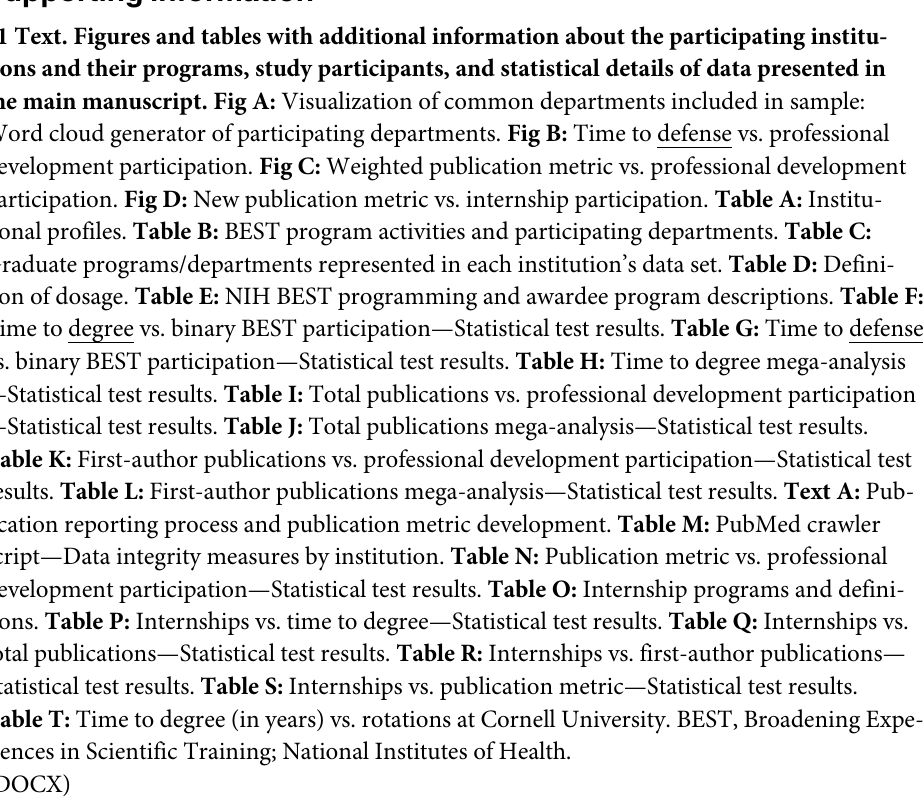
development participation. Fig C: Weighted publication metric vs. professional development participation. Fig D: New publication metric vs. internship participation. Table A: Institu- tional profiles. Table B: BEST program activities and participating departments. Table C: Graduate programs/departments represented in each institution’s data set. Table D: Defini- tion of dosage. Table E: NIH BEST programming and awardee program descriptions. Table F: Time to degree vs. binary BEST participation—Statistical test results. Table G: Time to defense vs. binary BEST participation—Statistical test results. Table H: Time to degree mega-analysis —Statistical test results. Table I: Total publications vs. professional development participation —Statistical test results. Table J: Total publications mega-analysis—Statistical test results. Table K: First-author publications vs. professional development participation—Statistical test results. Table L: First-author publications mega-analysis—Statistical test results. Text A: Pub- lication reporting process and publication metric development. Table M: PubMed crawler script—Data integrity measures by institution. Table N: Publication metric vs. professional development participation—Statistical test results. Table O: Internship programs and defini- tions. Table P: Internships vs. time to degree—Statistical test results. Table Q: Internships vs. total publications—Statistical test results. Table R: Internships vs. first-author publications— Statistical test results. Table S: Internships vs. publication metric—Statistical test results. Table T: Time to degree (in years) vs. rotations at Cornell University. BEST AU : AnabbreviationlisthasbeencompiledforthoseusedinS 1 Text : Pleaseverifythatallentriesarecorrect : , Broadening Expe- riences in Scientific Training; National Institutes of Health.